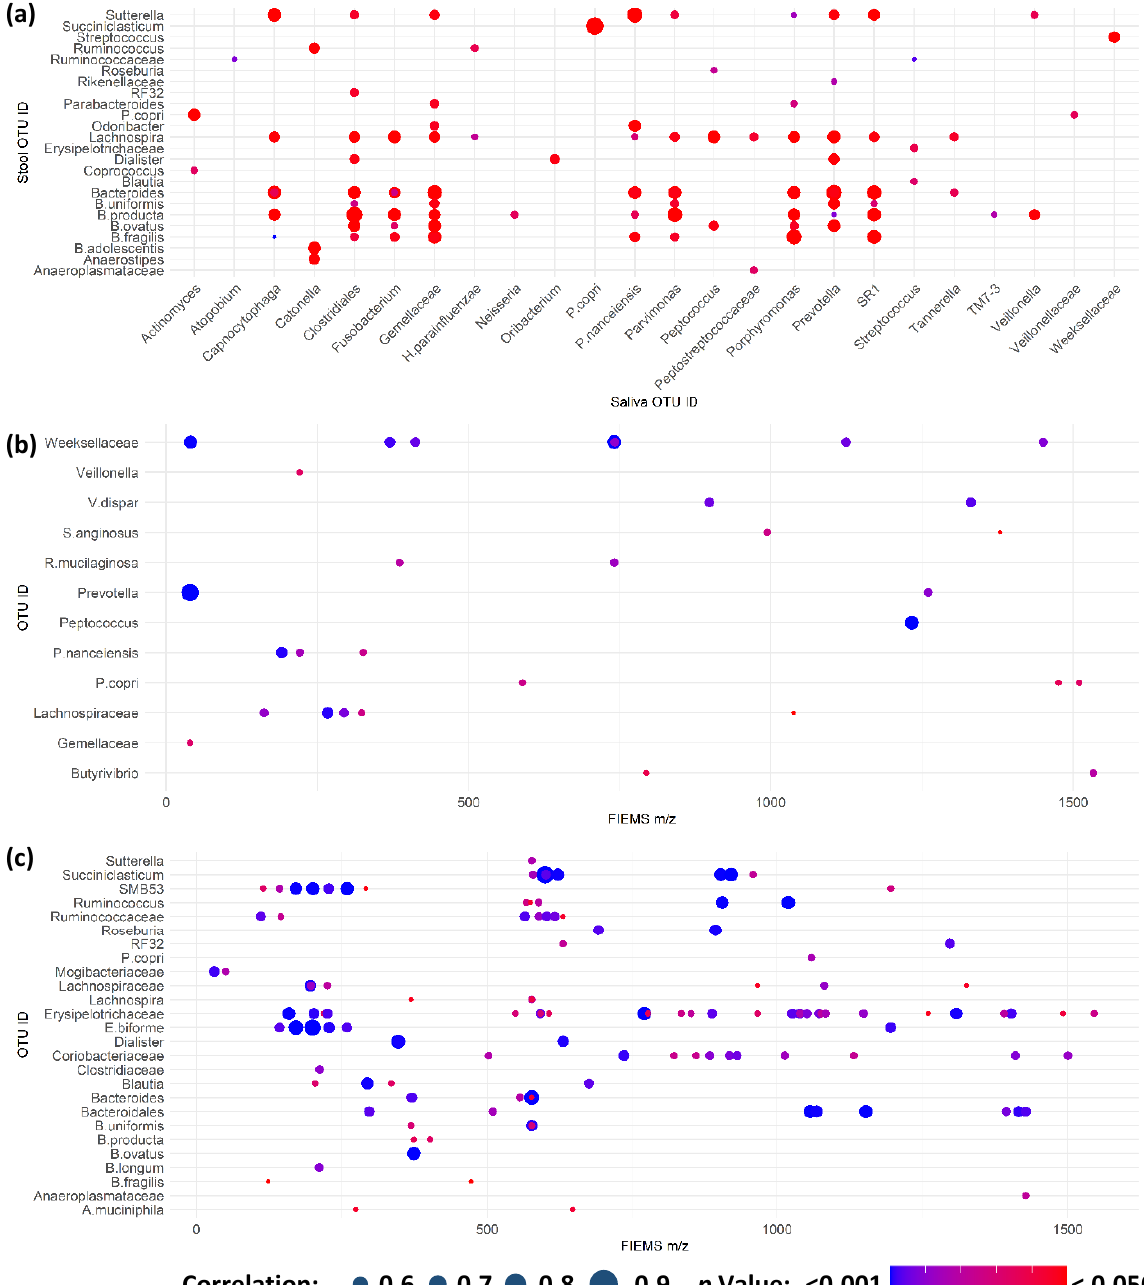
Figure 6. Multi-omic correlations indicate potential for microbiota modulation in extreme stress. ( a ) Significant correlations between metataxonomic features in saliva and stool samples from the same participant and sampling timepoint; ( b ) significant correlations between salivary metataxonomic and metabolite fingerprinting features; and ( c ) significant correlations between stool metataxonomic and metabolite fingerprinting features. Across all panels, only those features with at least one significant correlation are shown. Size of point is indicative of strength of correlation with only positive correlations identified in analysis. Colour of point is indicative of Bonferroni-corrected p value.